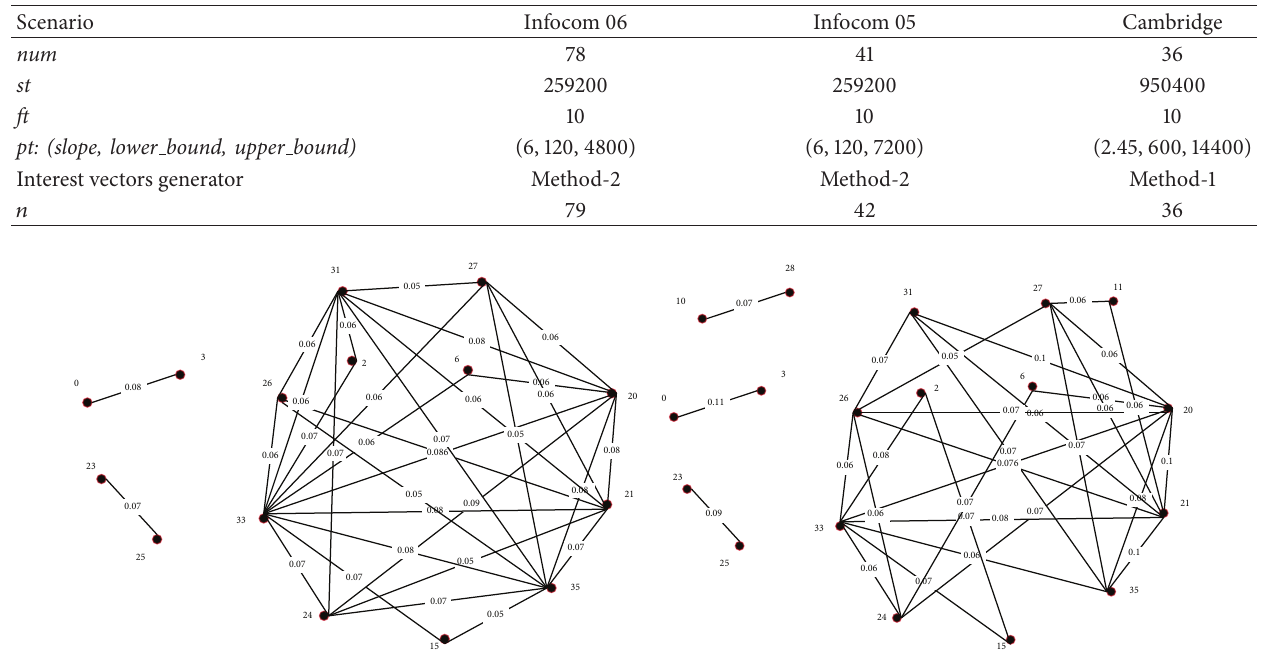
Figure 10: Comparisons between Cambridge trace and IHC: meaningful social relationships.